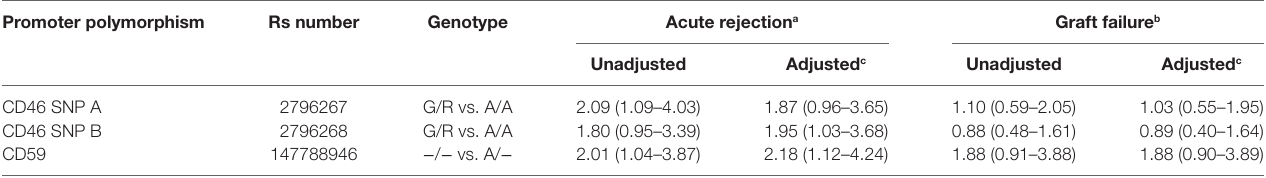
TaBle 3 | Hazard ratios (HRs) for acute rejection and graft failure.